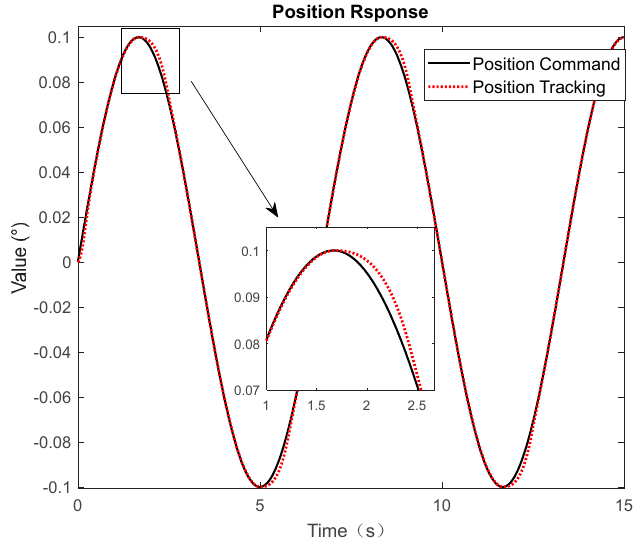
Figure 3. Position response under friction.